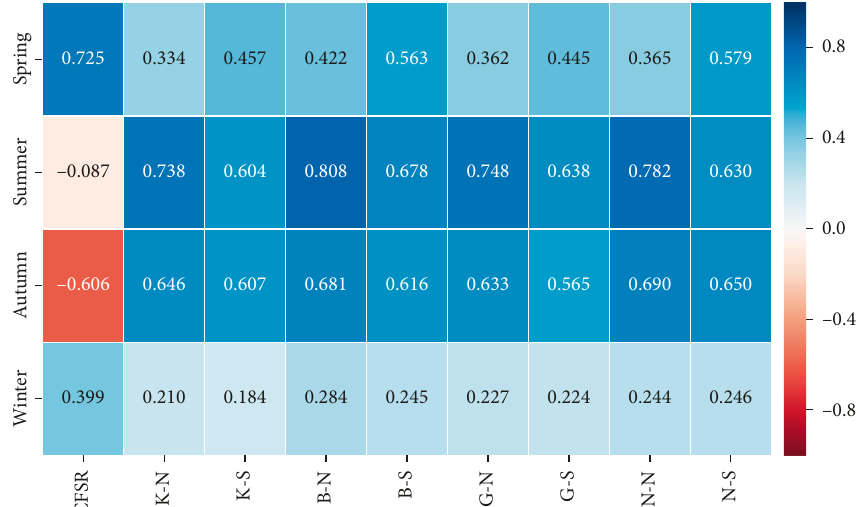
Figure 8: Pattern correlations of convective available potential energy between CFS reforecasts, the WRF model, and ERA-5 reanalysis for the period of 1999–2010.